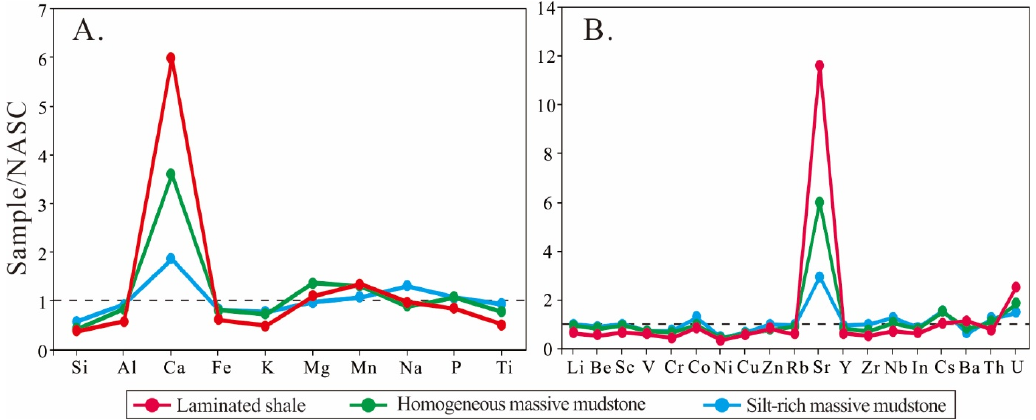
Figure 4. Major and minor elements distribution of the lithofacies. ( A ) Major elements abundance relative to the NASC; ( B ) minor elements abundance relative to the NASC.